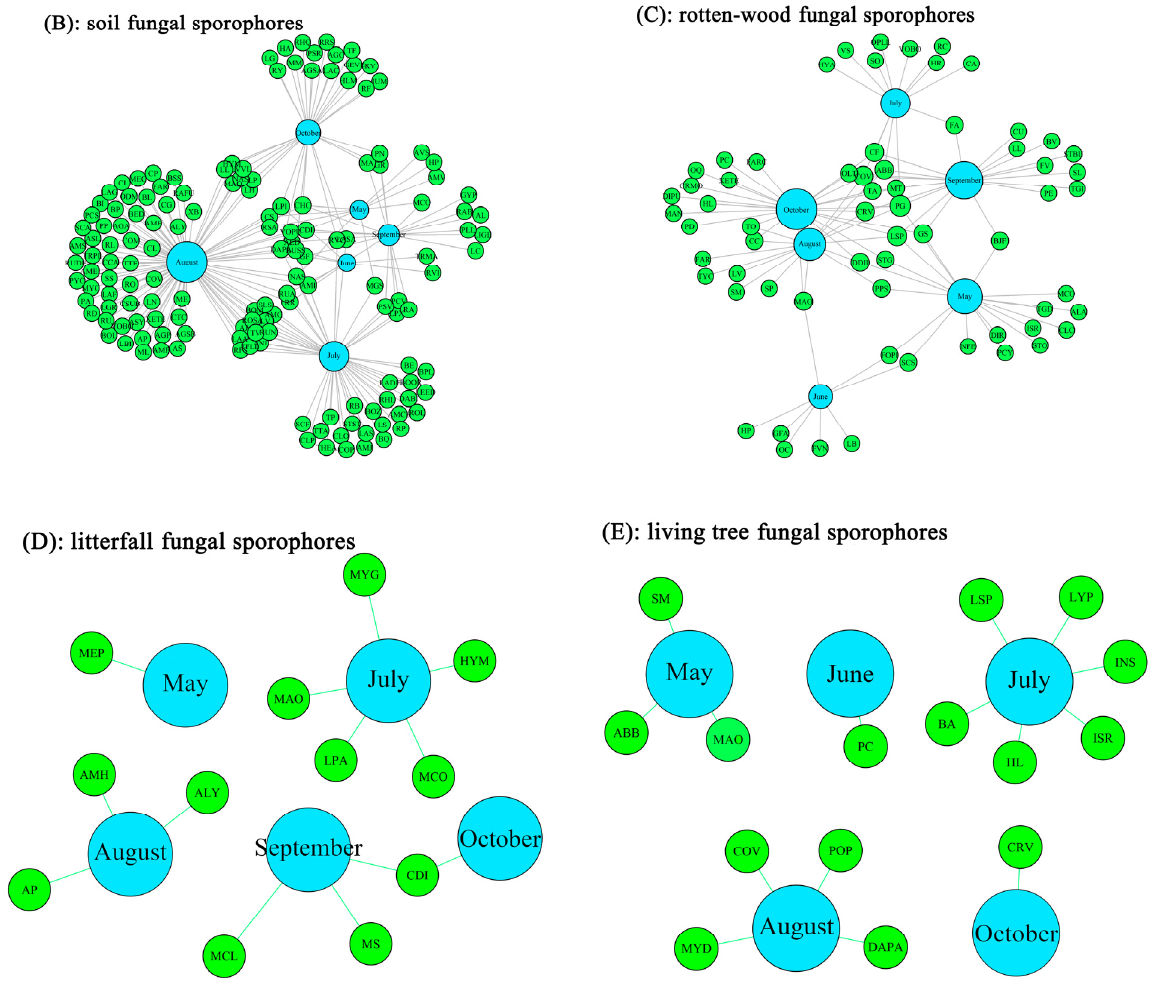
Figure 3. Network diagram of the fungal sporocarps–month network in a temperate forest in China. The network includes 217 species of fungal sporocarps, including 150 soil fungal sporocarps, 64 rotten-wood fungal sporocarps, 12 litterfall fungal sporocarps, and 15 living-tree fungal sporocarps. The thickness of lines and the size of rectangles represent the number of observed associations.